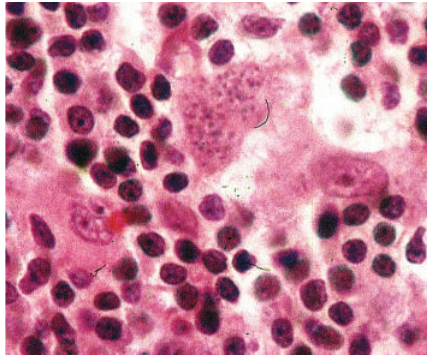
Figure 5: High power view of Leishmania organisms.